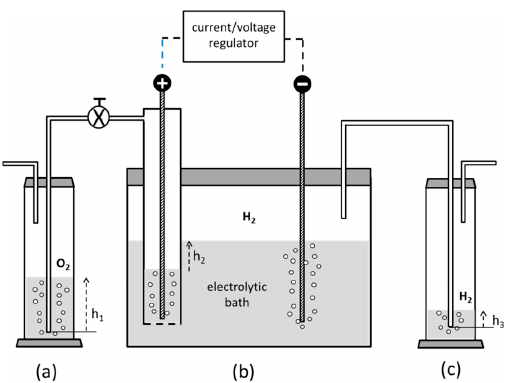
Figure 6. Scheme of the experimental apparatus for the preparation of the reductant (VSO 4 ). ( a , c ) are Drechsel bottles where the gases produced at the anodic and cathodic compartments of the electrolytic cell; ( b ) are made to bubble in water. The difference in liquid height h 2 between the interior and the exterior of the anodic compartment is regulated by properly setting the levels h 1 and h 3 at the beginning of the